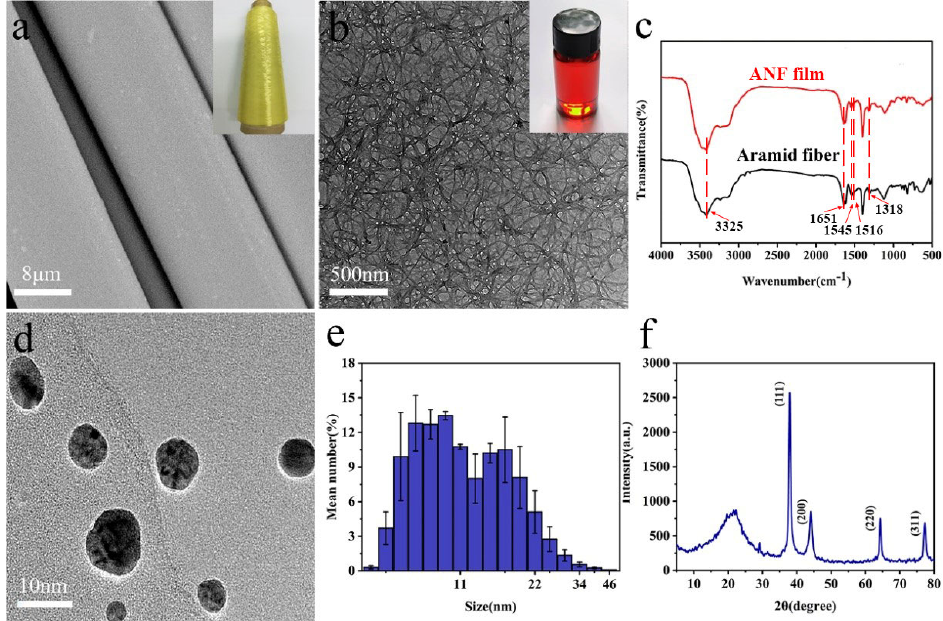
Figure 2. ( a ) SEM image and digital photograph (the inset) of the aramid fibers; ( b ) TEM image and digital photograph (the inset) of the ANF dispersion; ( c ) FTIR spectra of the aramid fiber and ANF film; ( d ) TEM image; ( e ) size distribution; and ( f ) XRD spectrum of the Ag NPs. Digital photographs, cross sections and surface morphologies of the ANF films pre ‐ pared by different amounts of the ANF dispersion are shown in Figure 3. With the in ‐ crease of the amounts of the ANF dispersion, the color of the ANF films gradually deep ‐ ened (Figure 3a–e), and the thickness of the ANF films increased from 1.5 to 10.6 μ m (Fig ‐